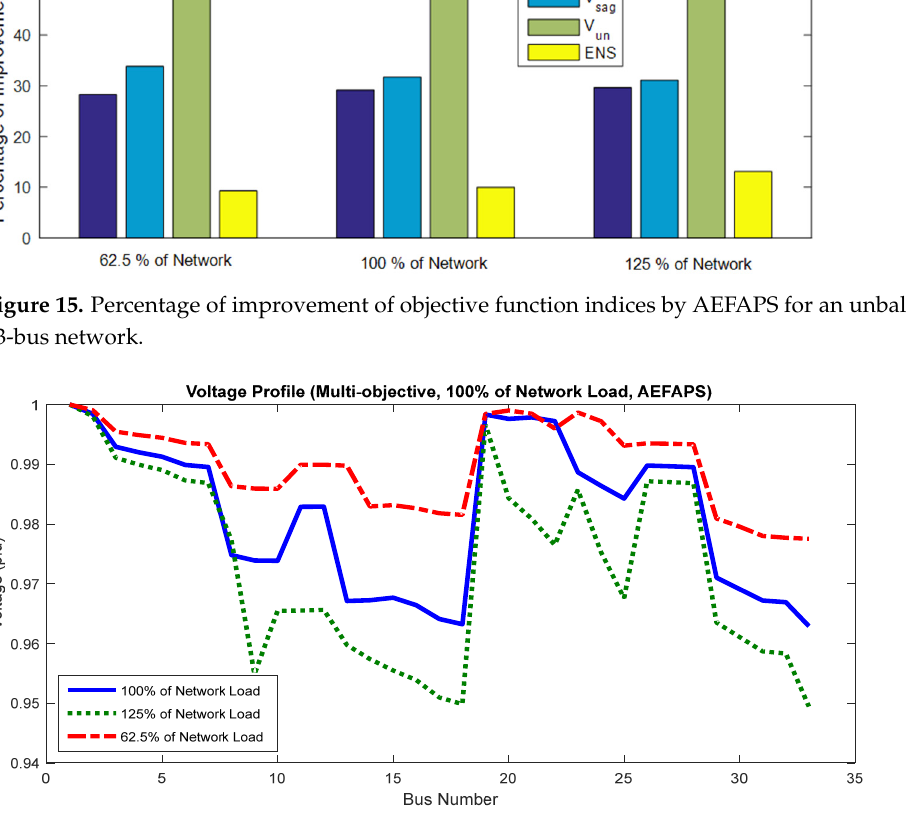
Figure 16. The 33-bus network voltage profile in loadings via AEFAPS with reconfiguration.